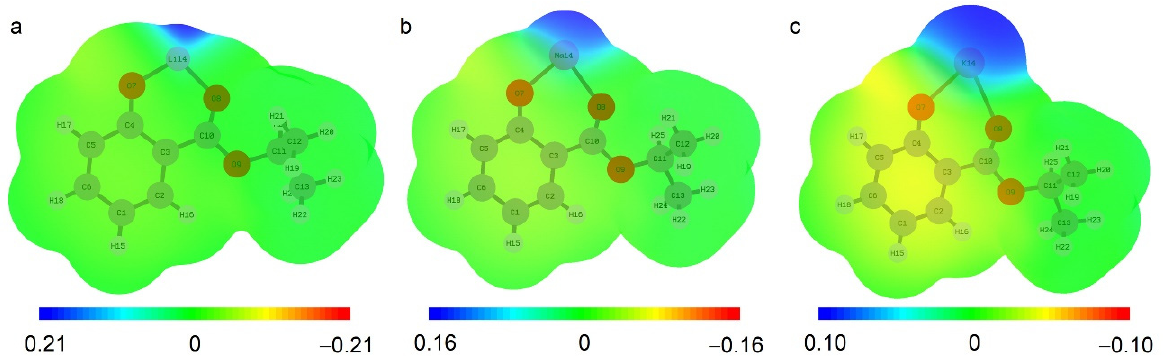
Figure 11. Electron density from the total SCF density (isoval = 0.0004) mapped with the electrostatic potential (ESP) for LiL ( a ), NaL ( b ), and KL ( c ).